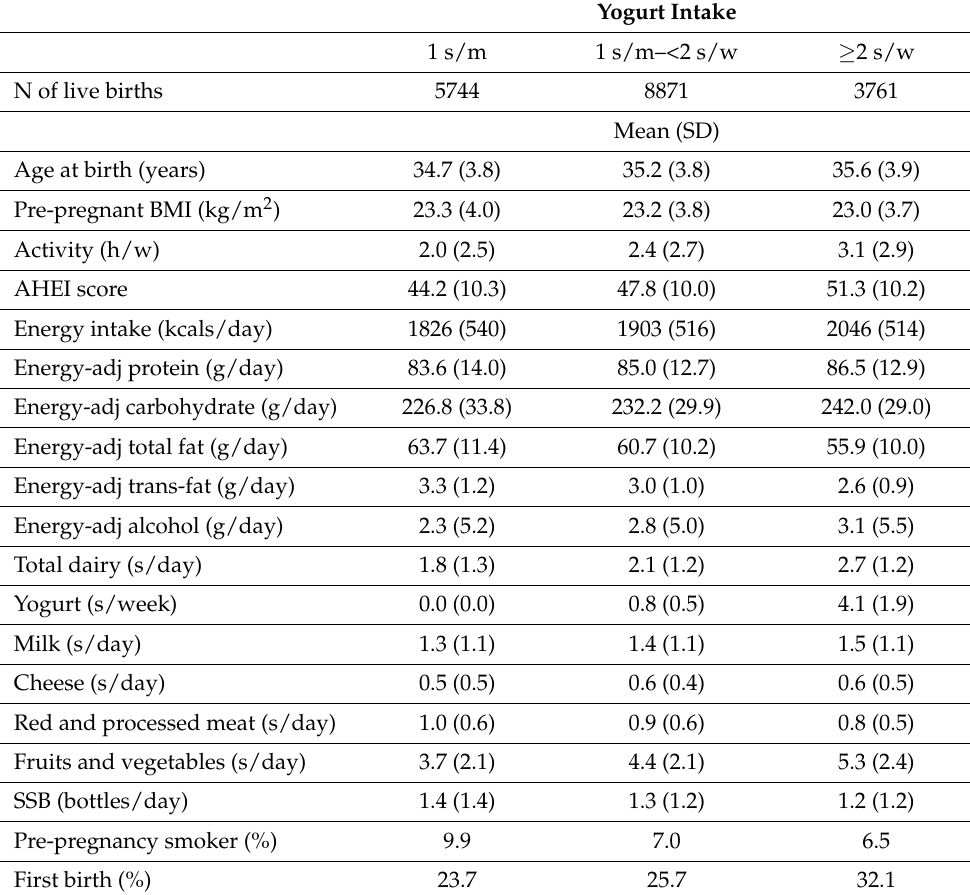
Table 1. Diet and Lifestyle Characteristics of Women in the Postpartum Weight Retention Analysis by Categories of Yogurt Intake throughout the 4 Years Surrounding Pregnancy 1 . Yogurt